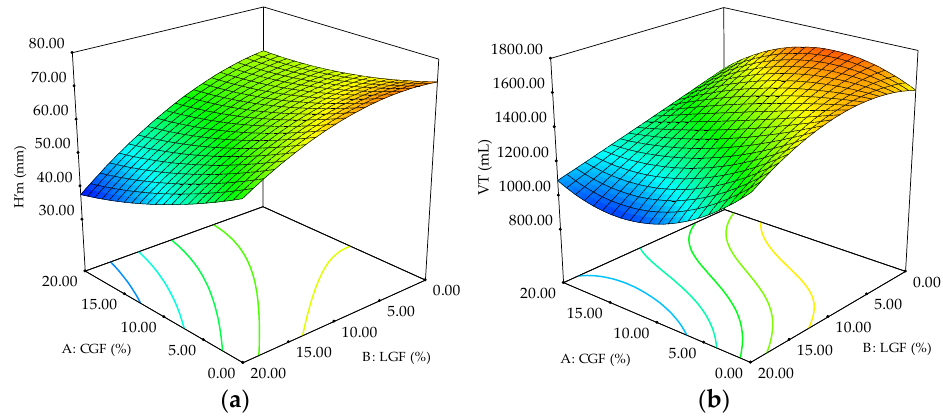
Figure 6. Response surface plot of ( a ) maximum height of the gas release curve (H’m) and ( b ) total